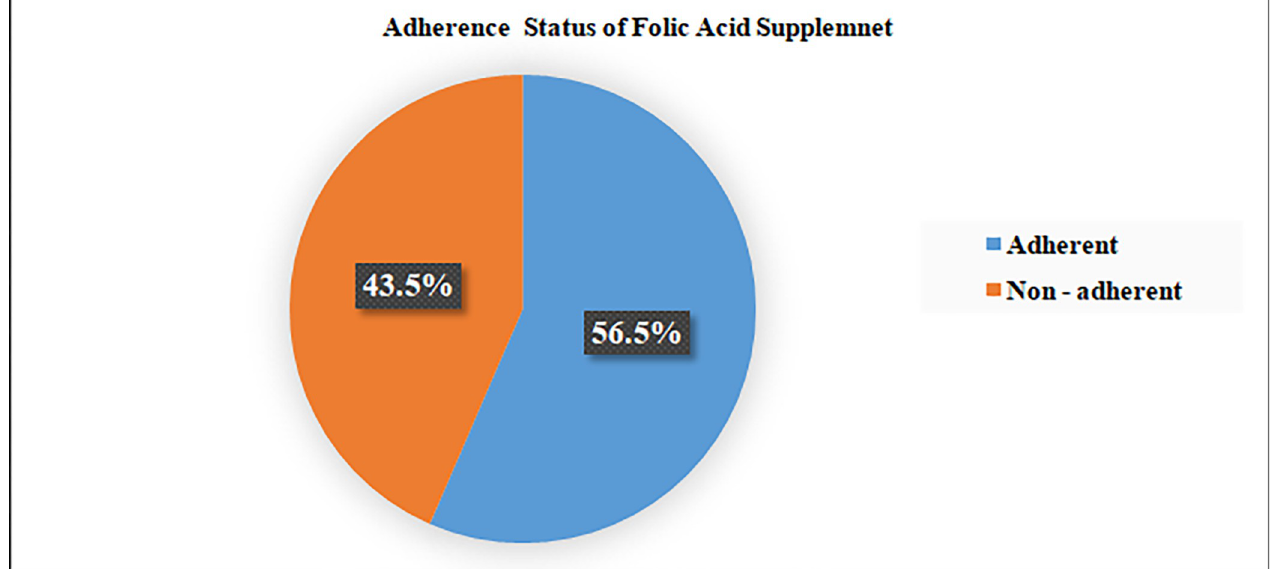
Fig 3. Level of adherence status of iron folic acid supplement among pregnant women attending public health facilities at Dire Dawa, Eastern Ethiopia.